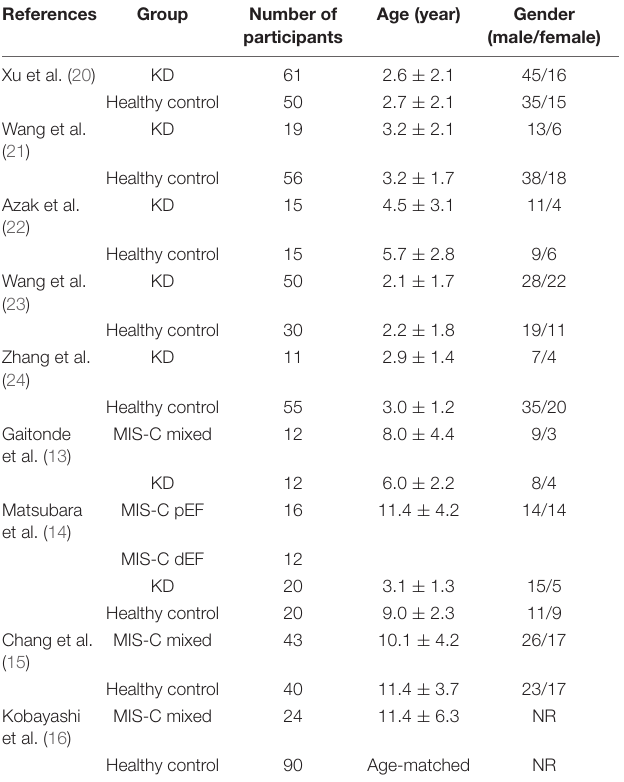
TABLE 1 | Characteristics of involved studies and comparisons of global myocardial strain among multisystem inflammatory syndrome in children, Kawasaki disease, and healthy